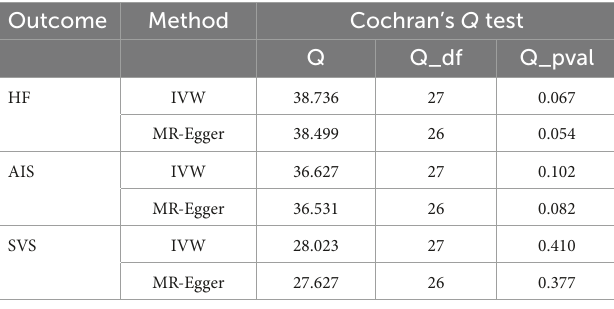
TABLE 2 Results of heterogeneity by Cochran’s Q test. Outcome